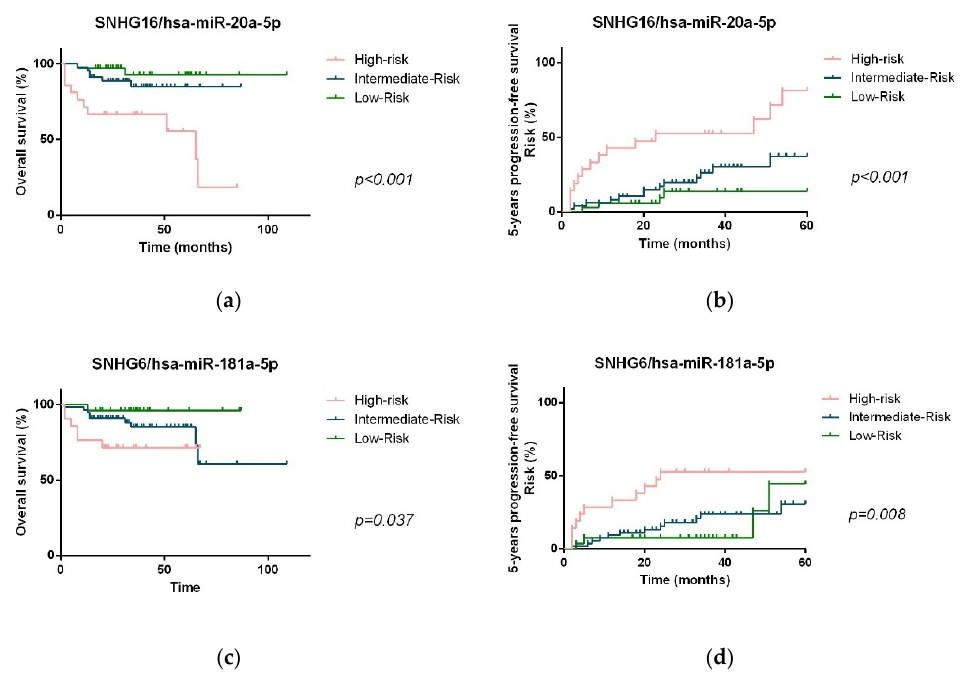
Figure 10. OS and PFS of NHL patients according to the defined risk groups based on the plasma levels of miRNA/lncRNA pairs, hsa-miR-20a-5p/SNHG16 ( a , b ) and hsa-miR-181a-5p/SNHG6 ( c , d ). Multivariate analysis was conducted with significant clinical parameters associated